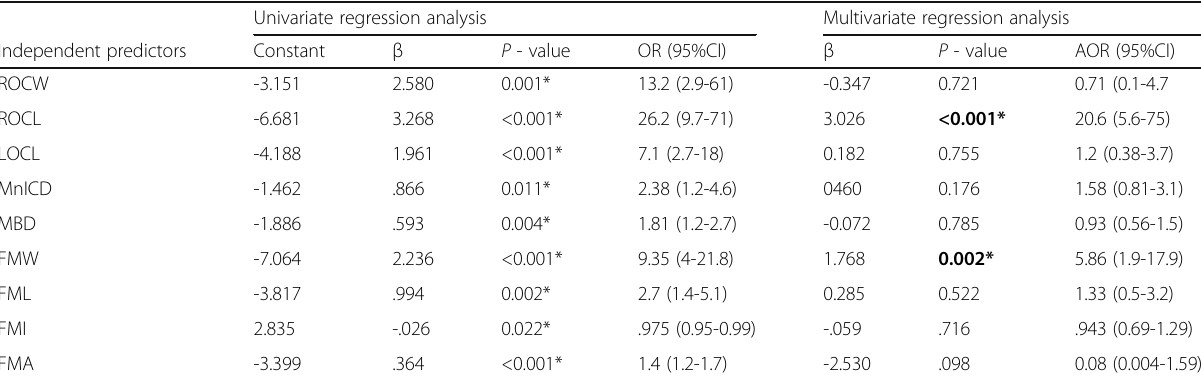
ROCW : Right occipital condylar width, ROCL : Right occipital condylar length, LOCL : Left occipital condylar length, MnICD : Minimum intercondylar distance, MBD : Maximum intercondylar distance, FMW : Foramen magnum width, FMI : Foramen magnum index, FML : Foramen magnum length, FMA : Foramen magnum area,